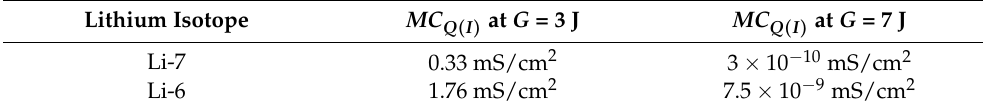
Table 15. The table shows that intracellular lithium isotopes can have a range of quantum membrane conductance from the value at G = 3 J to the value at G = 7 J according to the setting values in graph (a) of Figure 7.